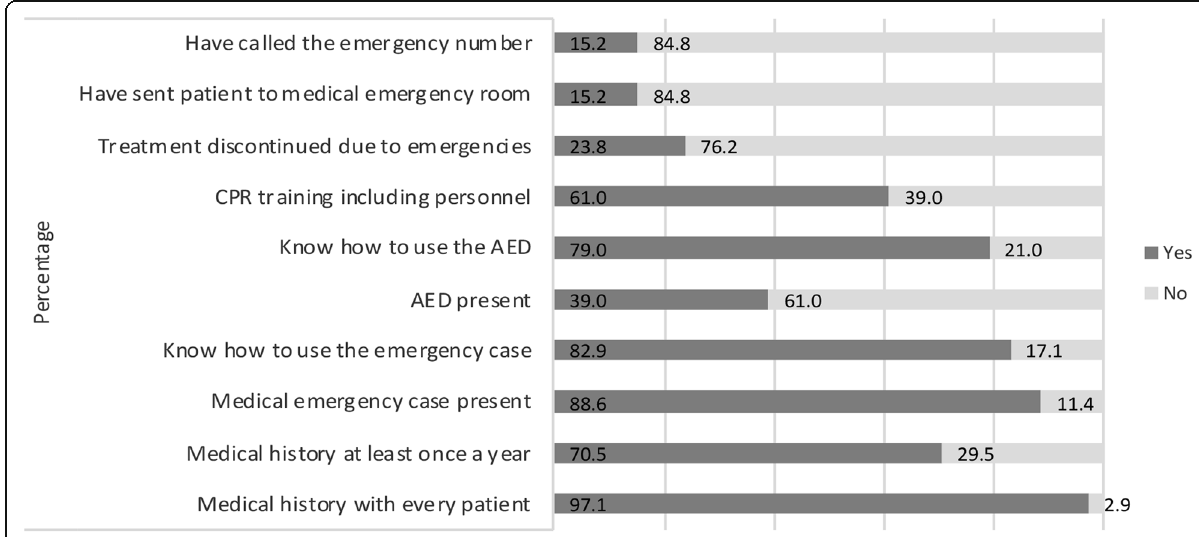
Fig. 1 Precautions against and experiences in acute medical emergencies in orthodontic